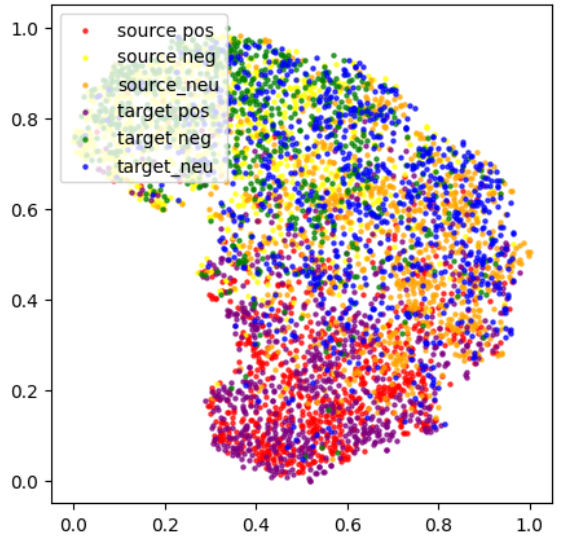
Figure 3. Visualization of feature representation on M → BK.